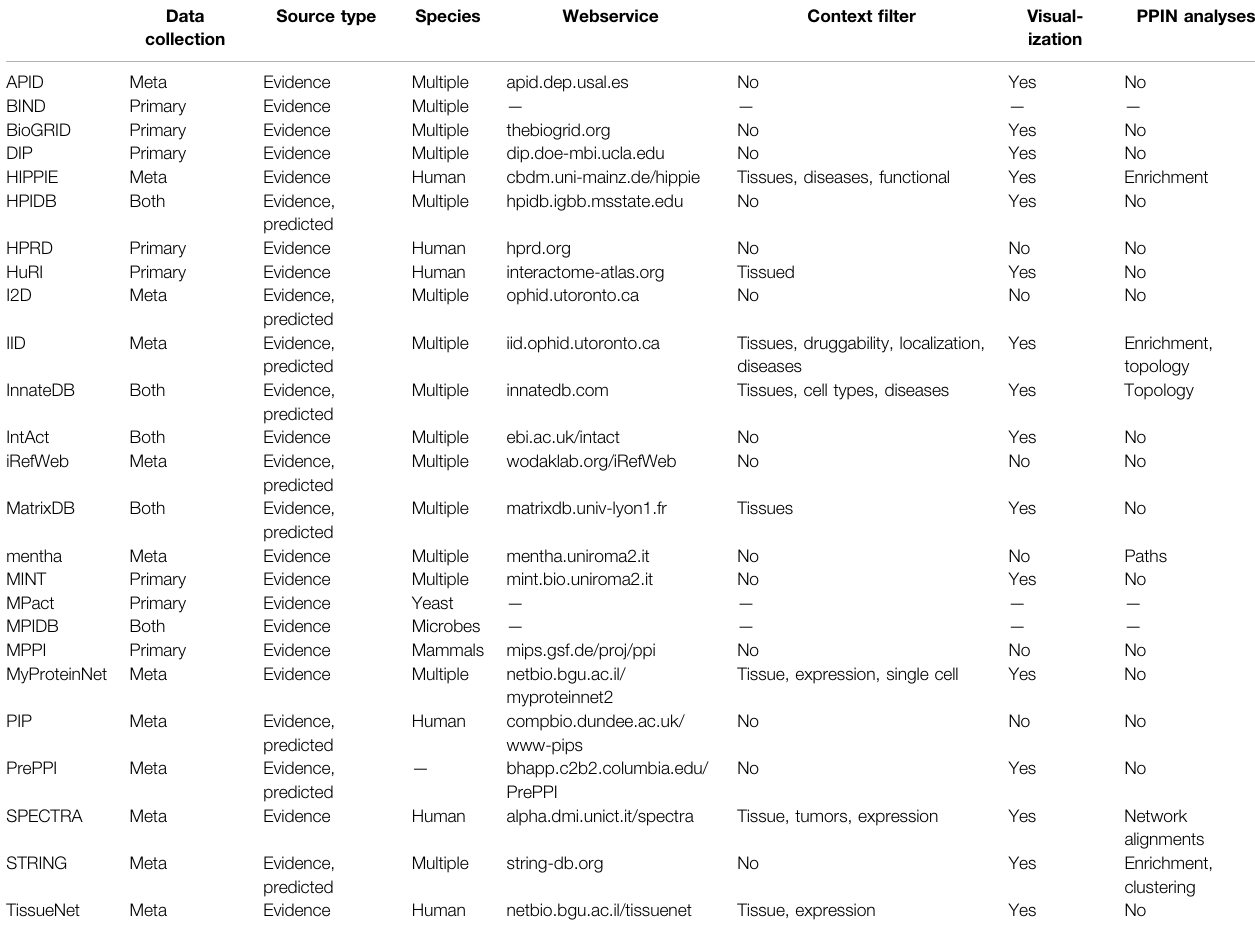
TABLE 1 | Overview of PPI databases and PPI network (PPIN) features of their webservice. Data